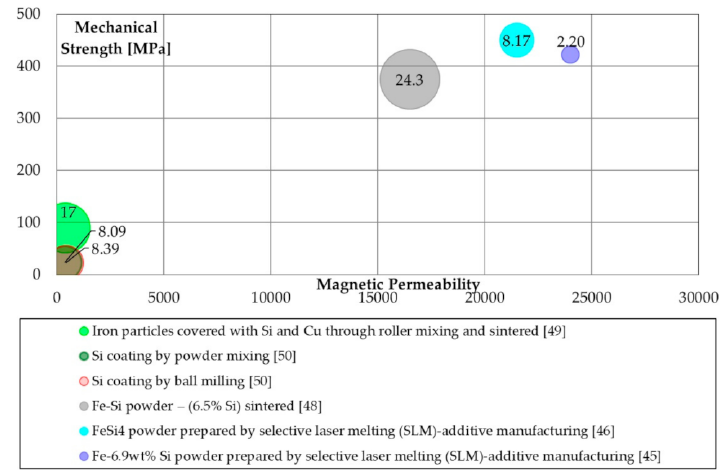
Figure 2. Magnetic (maximum permeability), mechanical (TRS [MPa]), and energetic properties (total iron losses 1 T@50 Hz [W/kg]) of Si coating